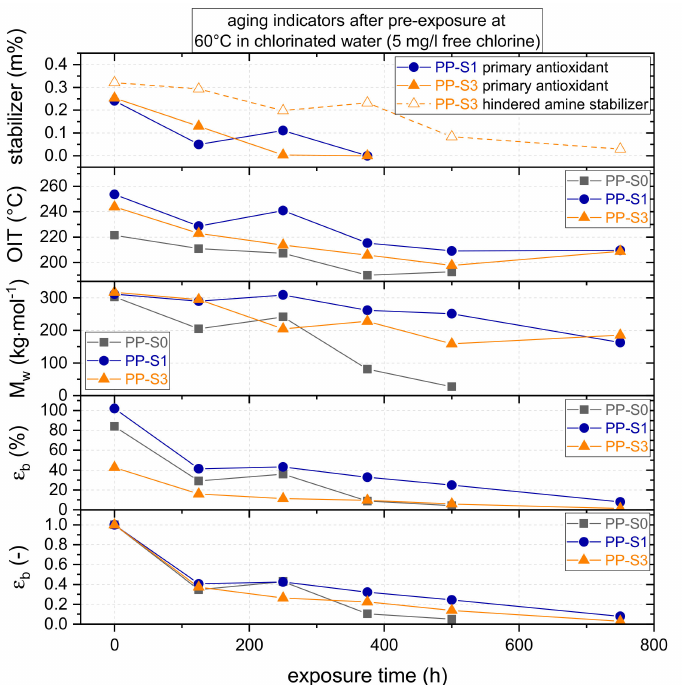
Figure 4. Stabilizer content (primary antioxidants and hindered amine stabilizer), dynamic oxidation induction temperature (OIT), mean weight average molar mass (M w ), strain at break ( ε b ), and normalized strain at break as a function of exposure time of micro-sized specimens for the three PP